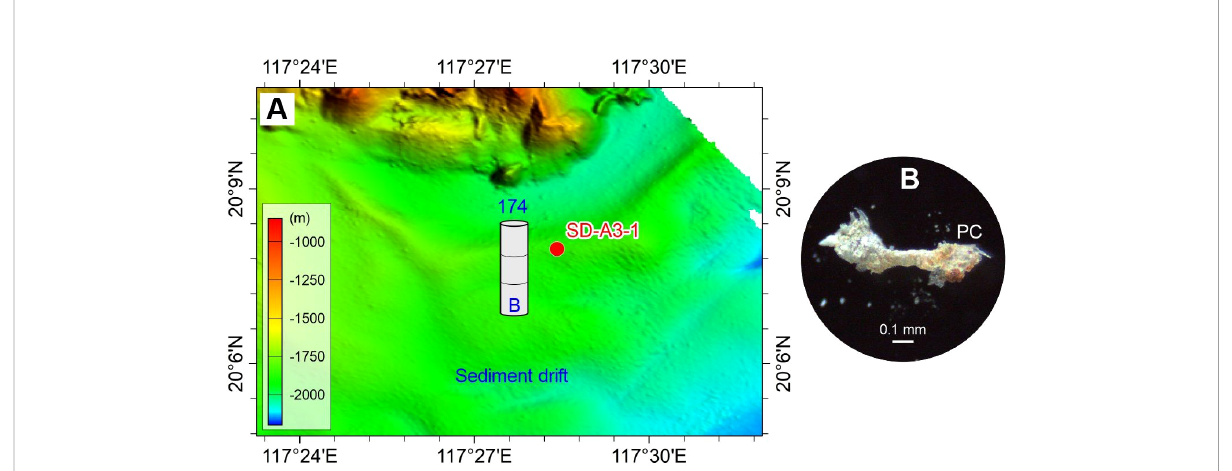
the differential sorting of various microplastic shapes may occur during the vertical settlement through the water column. The particle sizes of all microplastics in this study range from 0.07